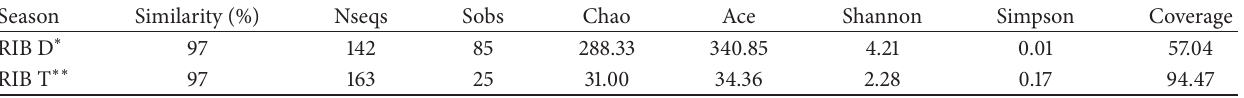
Table 2: 𝛼 -Diversity analysis for Cerrado freshwater lake sediment rRNA 16S gene sequences.